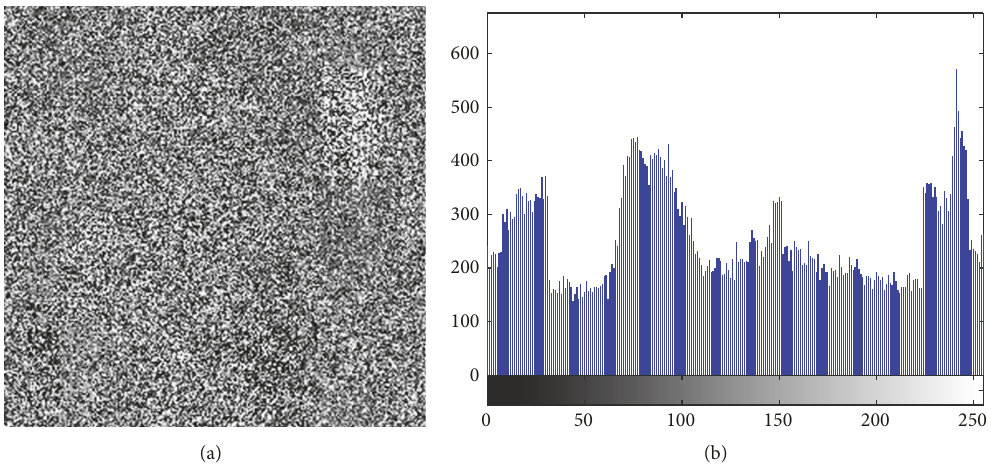
Figure 14: Case 2 : (a) encrypted image and (b) encrypted histogram.